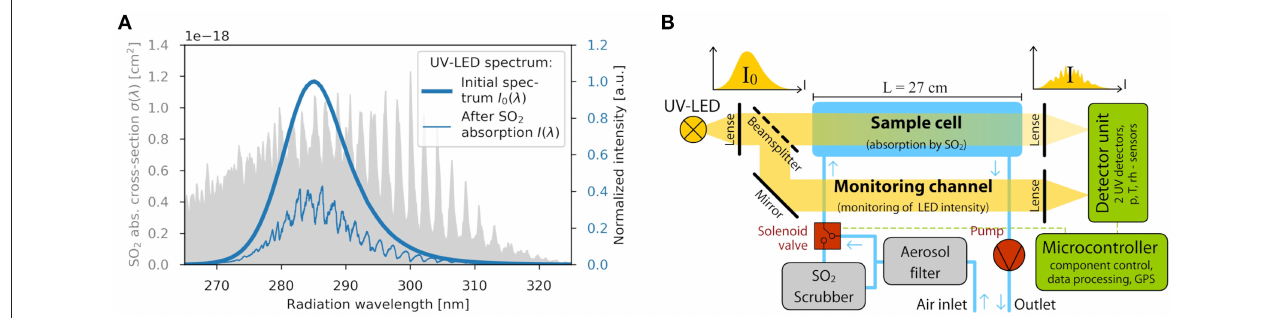
FIGURE 1 | (A) Wavelength dependence of the SO 2 absorption cross section (gray shaded area) and the spectrum of the UV-LED (thick blue line), as determined with a spectrometer. The thin blue line exemplarily shows the LED spectrum having passed a 27cm sample cell (as applied in the PITSA prototype) containing 1,000ppm SO 2 (volume mixing ratio). (B) Schematic of the PITSA prototype setup. The UV light in the sample cell is solely attenuated due to SO 2 absorption. By comparing the light intensities I 0 and I , the amount of SO 2 in the cell can be